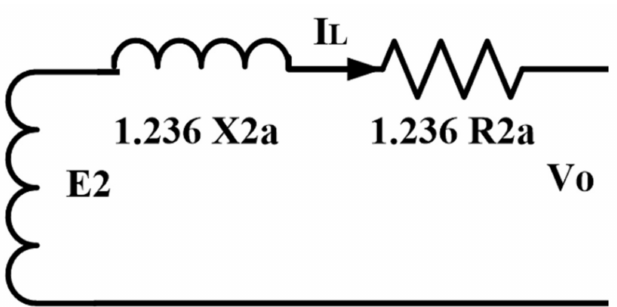
Figure 19. Per-phase equivalent circuit of the secondary side of the